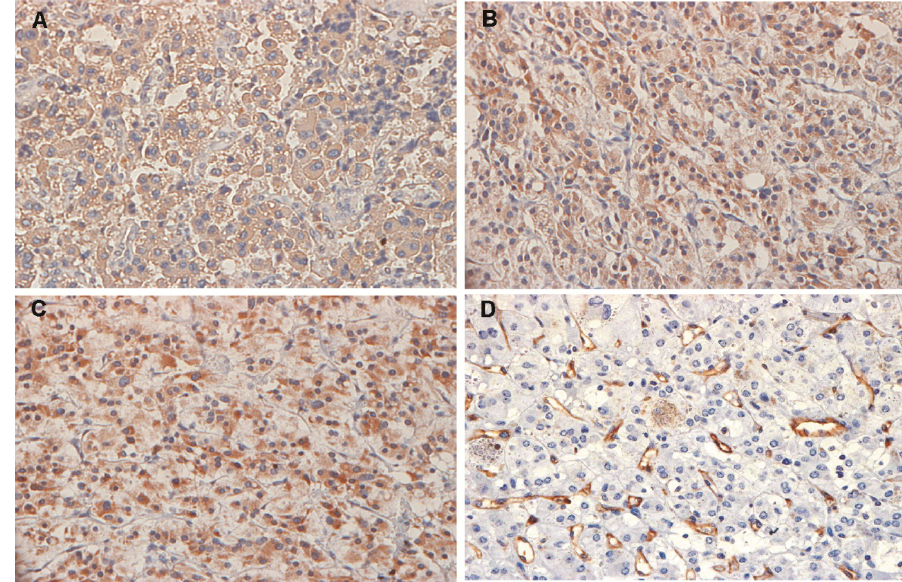
Figure 1. Representative immunohistochemical detection of vascular endothelial growth factor (VEGF-A), vascular endothelial growth factor receptor 1 and 2 (VEGFR-1 and VEGFR-2) and microvessels in tumor cells from PHEO samples (all images were acquired using a magnification of 400×). ( A ) VEGF-A in a malignant tumor sample; ( B ) VEGFR-1 and ( C ) VEGFR-2 in a sample of sporadic tumor; and ( D ) CD31-positively stained microvessels in a sample of MEN 2B-associated PHEO.